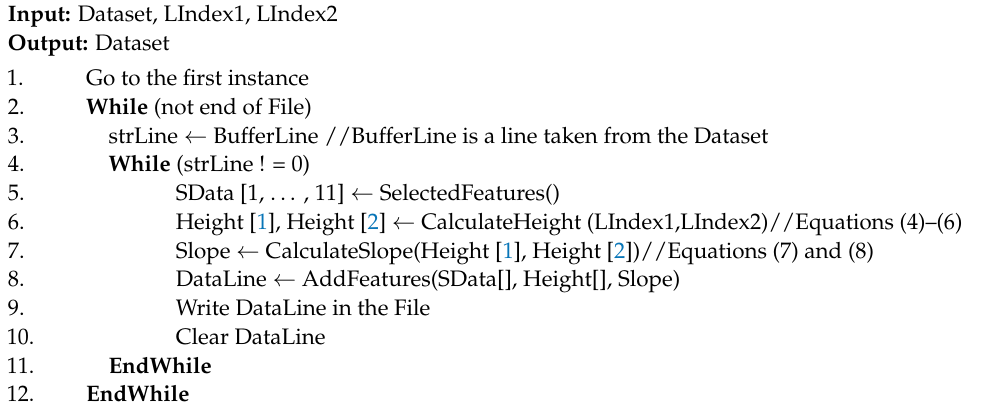
Algorithm 4: PreProFXModuleDL: Preprocessing and Feature Extraction